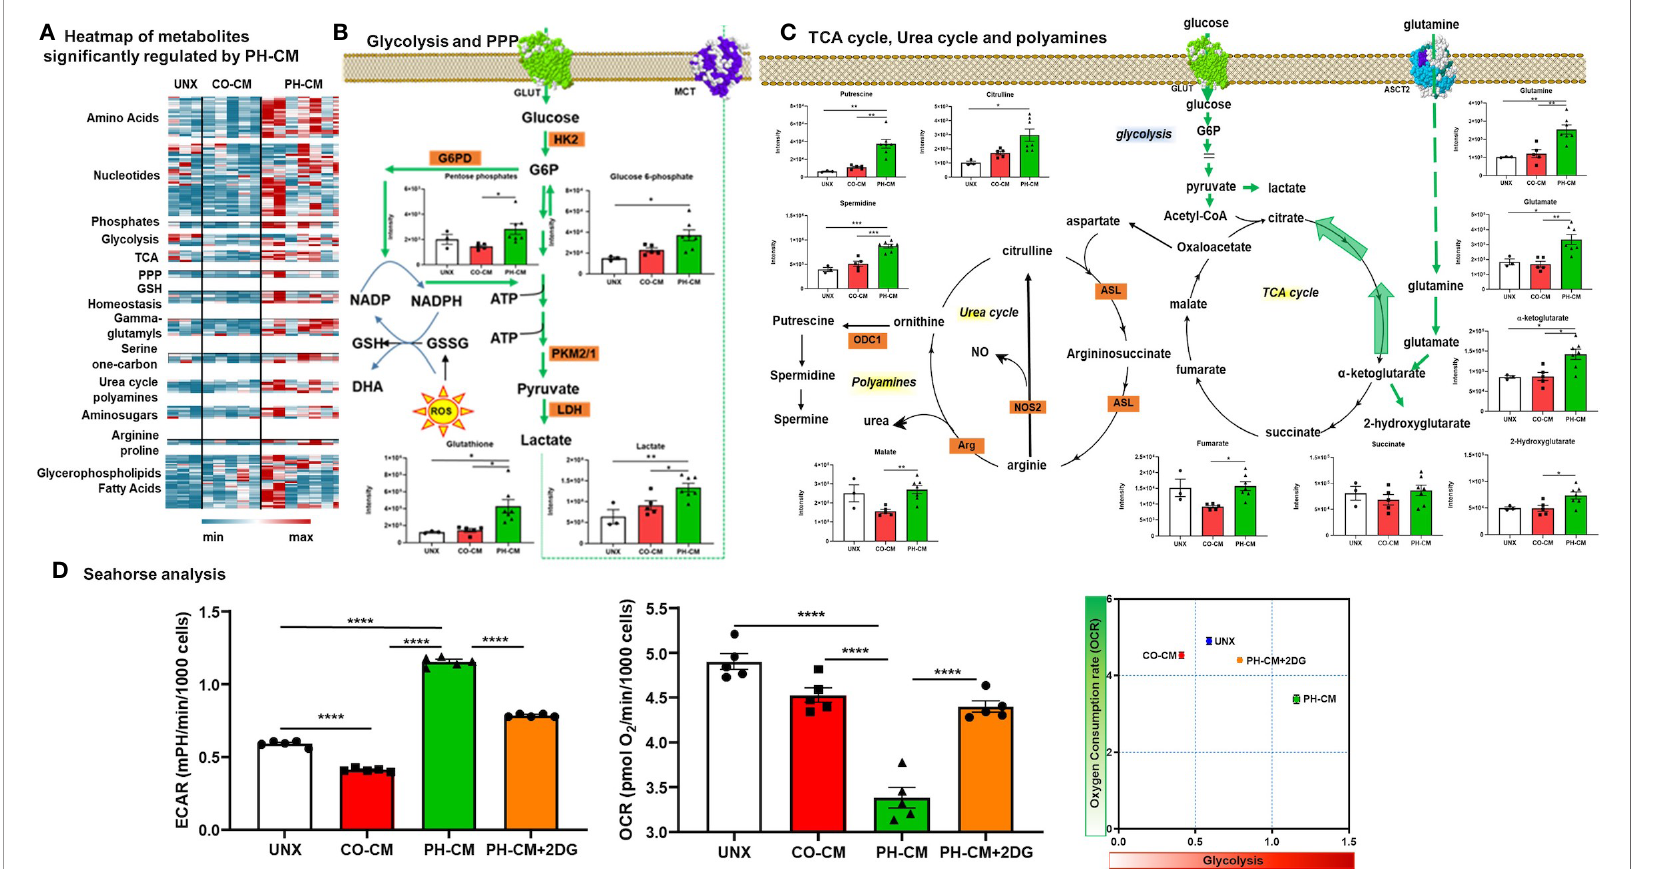
FIGURE 3 | Control and PH- fi broblast conditioned media have distinct effects on regulating macrophages metabolism. (A) Heat-map showing metabolites that are signi fi cantly regulated by PH-CM compared to CO-CM treated or untreated BMDMs (One-way ANOVA: p ≤ 0.05). (B) Metabolites in glycolytic or pentose phosphate pathway (PPP) that were signi fi cantly increased by PH-CM compared to untreated or CO-CM treated BMDMs. * p < 0.05, ** p < 0.01. (C) Metabolites in glutaminolysis, TCA cycle, urea cycle or polyamine synthesis that were signi fi cantly increased by PH-CM compared to untreated or CO-CM treated BMDMs. * p < 0.05, ** p < 0.01, *** p < 0.001. (D) CM was collected from CO-Fibs, PH-Fibs or PH-Fibs treated with 2DG. BMDM was exposed to CM for 18hrs prior to their analysis for extracellular acidi fi cation rate (ECAR) and oxygen consumption rate (OCR) were measured with Seahorse XF96 analyzer to determine macrophage glycolysis and mitochondrial OXPHOS. **** p <